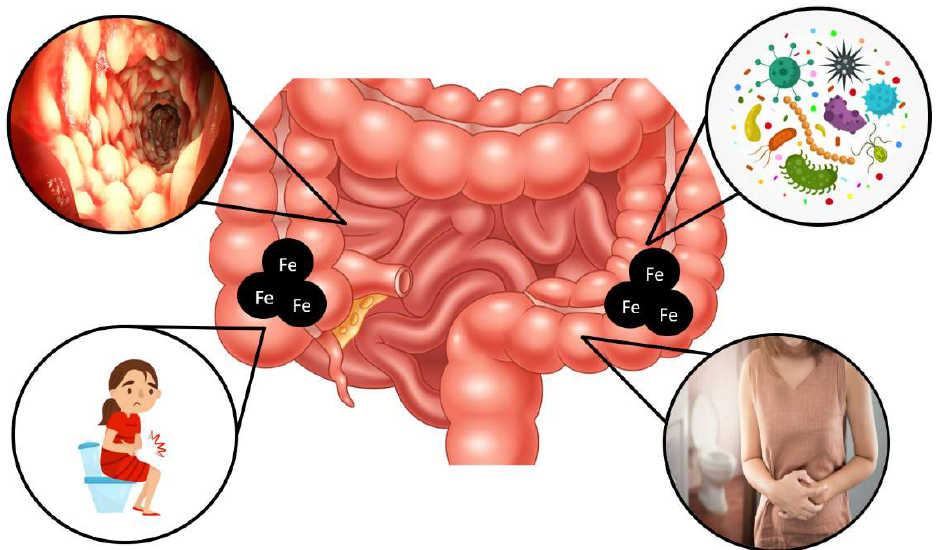
Figure 2. Summary of the impact of iron on the GI tract. Oral iron supplementation causes up to 60% of patients to report gastrointestinal side effects such as constipation, nausea, and bloating. Iron is known to cause intestinal inflammation via the production of ROS. Iron also causes changes to the gut microbiota by increasing the level of enteropathogens and decreasing protective species and may cause changes to archaeal species.